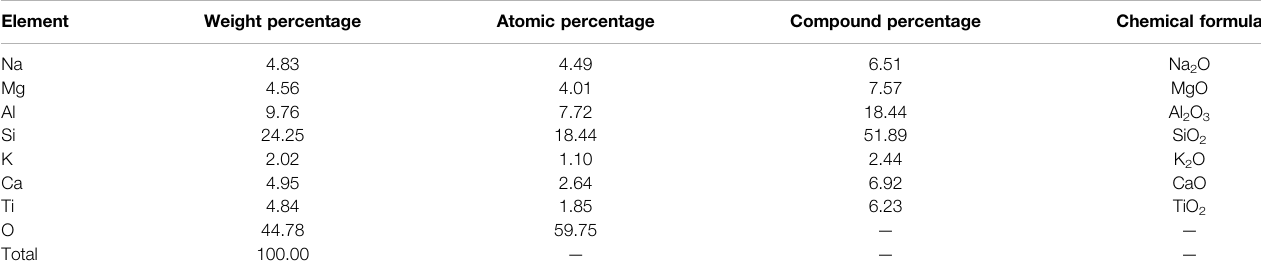
TABLE6| Elementalcompositionforselectedareasintheone-partgeopolymer-stabilizedsoilsamplewith80%GGBFSand20%FAat6.50 mol/LNHsolutionforN-A-S-H. Element Weight percentage Atomic percentage Compound percentage Chemical